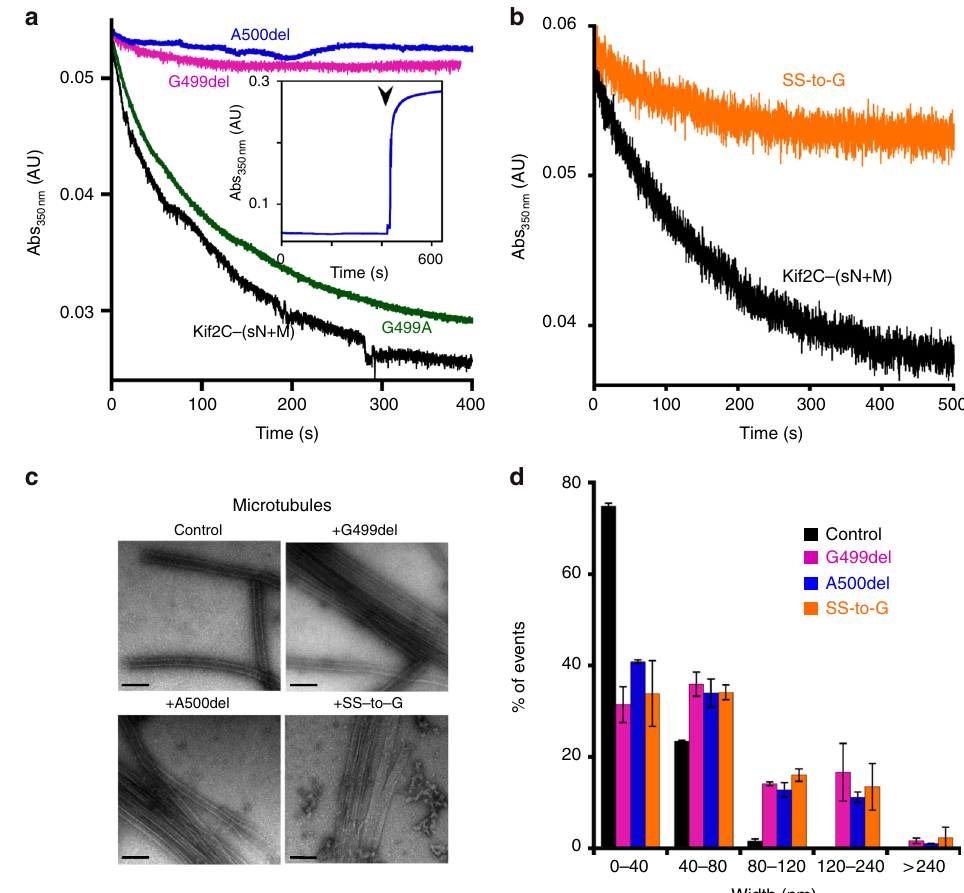
Fig. 4 The kinesin-13 speci fi c one-residue insertion in the L11 loop is required for microtubule depolymerization. a , b Turbidity traces of 2 μ M microtubules in the presence of 0.1 μ M wild-type Kif2C-(sN+M) or of Kif2C proteins mutated in the L11 loop, as indicated. In the case of deletion mutants, the turbidity signal increased when higher Kif2C concentrations were tested (inset of panel a , 1 μ M extra A500del added at the time indicated by the arrow head ). c Negative staining electron microscopy images of 2 μ M microtubules alone or incubated with 1 μ M shortened L11 loop mutants, as indicated. Scale bar, 100 nm. d Quanti fi cation of the bundling activity. The width of microtubule species (isolated microtubules or bundles) from two independent electron microscopy experiments was measured. Number of measured species: microtubule control, n = 90 and n = 97 ( fi rst and second experiments, respectively); microtubules incubated with G499del, n = 87 and n = 96; with A500del, n = 89 and n = 97; with SS-to-G, n = 86 and n = 95. Error bars are s.d. calculated from these two